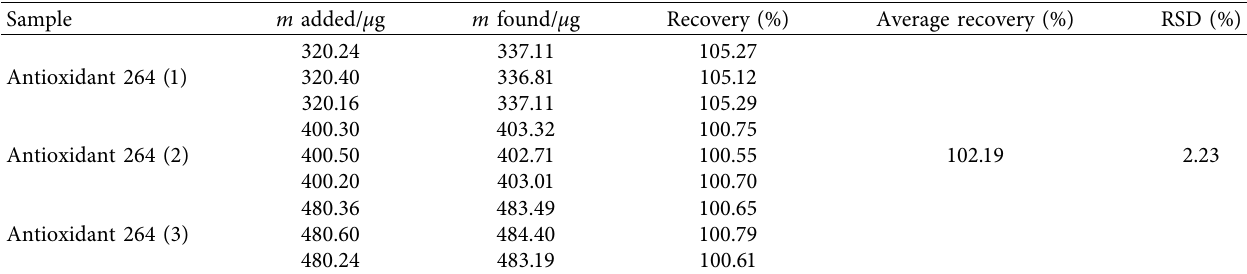
Table 2: Recovery of antioxidant 264 in recombinant potent antitumor and antivirus protein